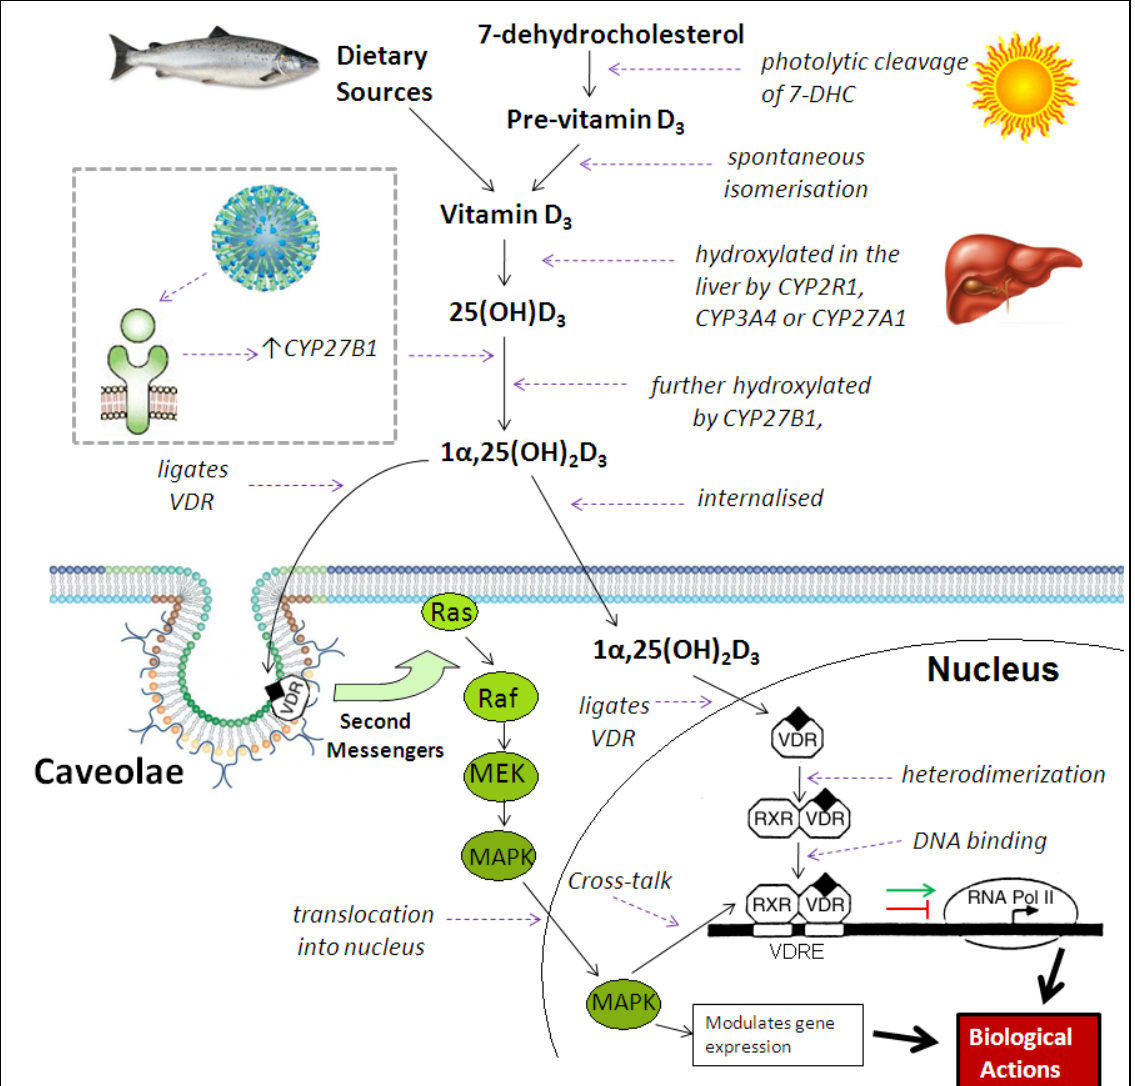
Figure 2. Metabolism of 1α,25(OH) 2 D 3 . Vitamin D 3 is either obtained from dietary sources or UV synthesis, before two hydroxylations occur to produce the active metabolite 1α,25(OH) 2 D 3 . TLR ligation can also increase levels of CYP27B1, resulting in enhanced 1α-hydroxylation of 25(OH)D 3 . The 1α,25(OH) 2 D 3 then binds to nuclear or membrane vitamin D receptors (VDRs). Nuclear VDR ligation results in heterodimerization with retinoid X receptor (RXR) and binding to vitamin D responsive elements (VDRE) in promoter regions of responsive genes. Components of the RNA polymerase II complex are then recruited for induction of gene transcription, or transcription is repressed. Membrane caveolae-associated VDR ligation results in the activation of second messenger systems, with one effect being the initiation of Ras/MAPK signal transduction. Nuclear MAPK modulates gene expression and engages in cross-talk with the VDR-RXR-VDRE complex. (Adapted from Slatopolsky et al. [104], and Parton and Simons